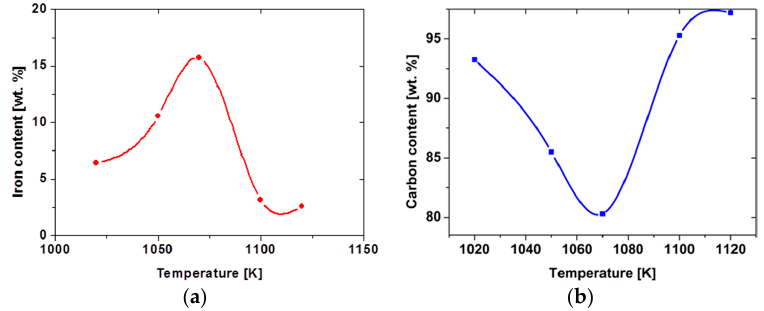
Figure 9. Plots of iron—( a ) and carbon—( b ) content versus synthesis temperature.